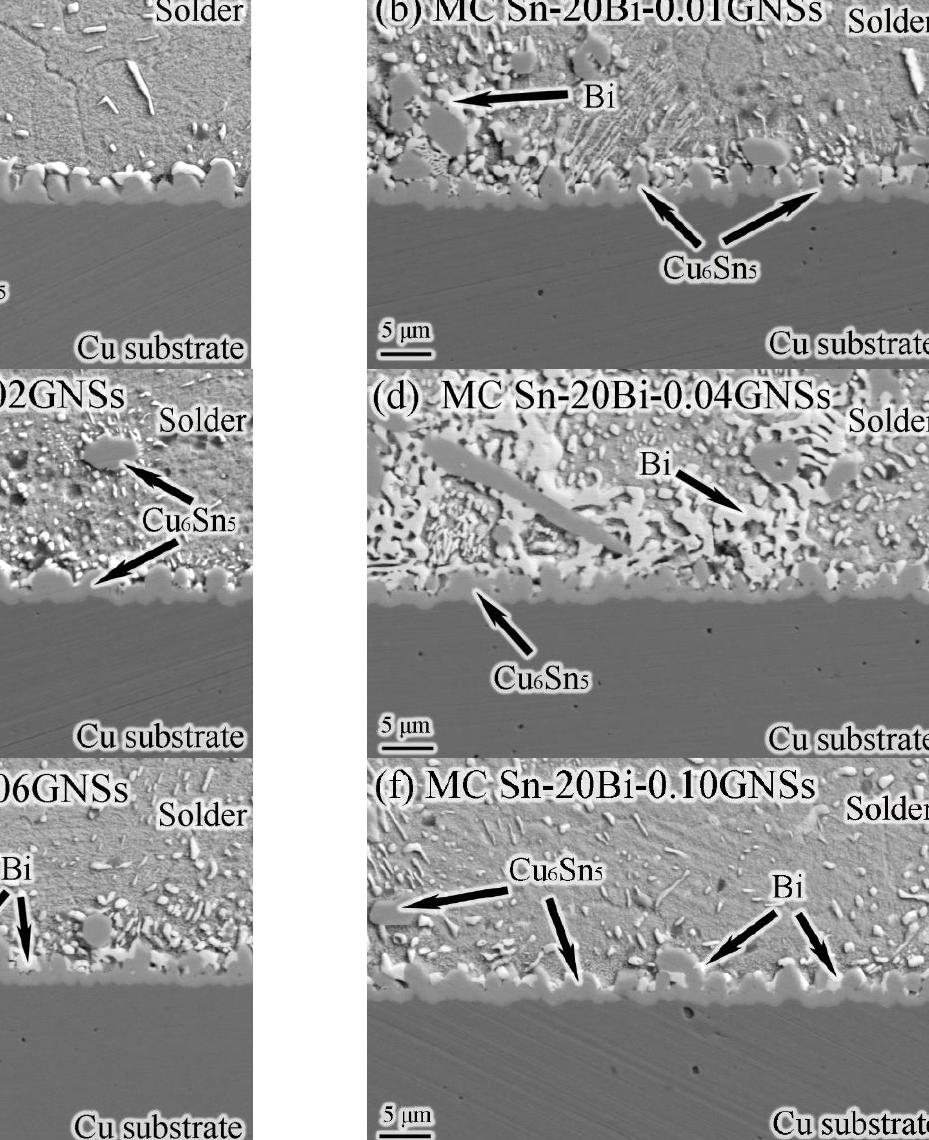
Figure 5. ( a ) Thickness of the IMC layer formed at MC Sn-20Bi- q GNSs/Cu and ( b ) shear strength of MC Sn-20Bi- q GNSs/Cu solder joint.